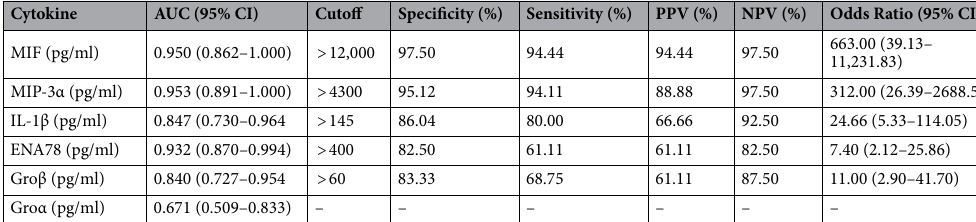
Cytokine AUC (95% CI)